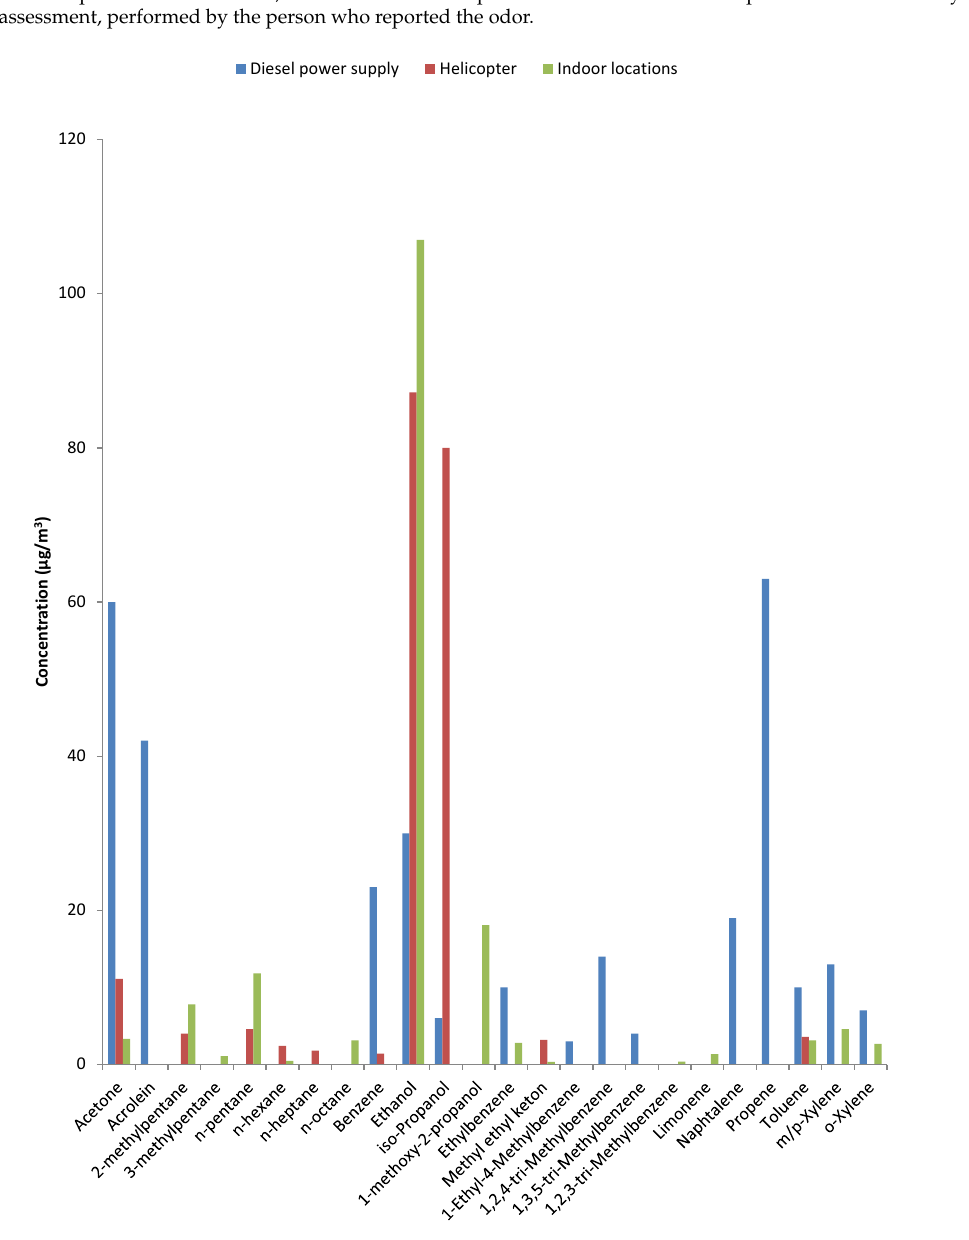
Figure 5. Comparison of VOC source profiles and mean VOC profile for indoor locations ( n =